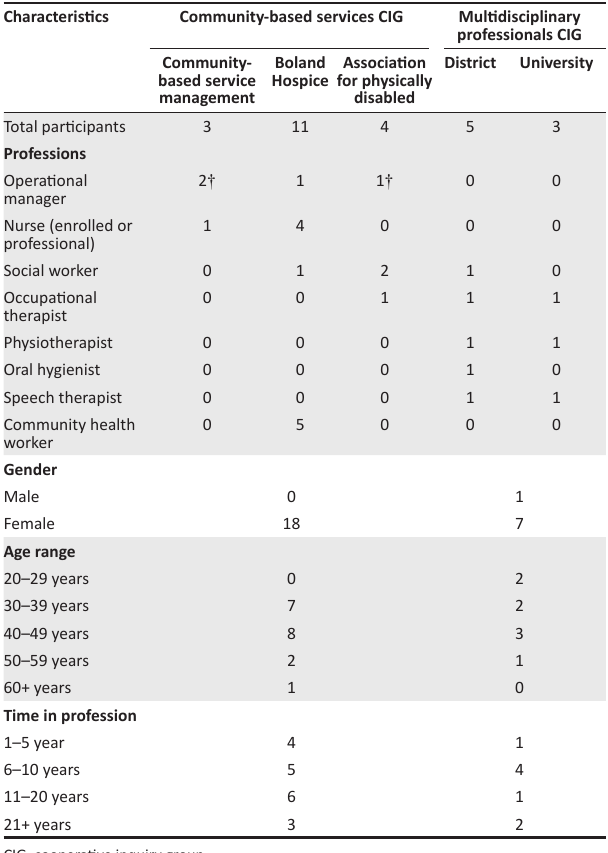
TABLE 2: Numbers of multidisciplinary professionals and community health workers in the Breede Valley